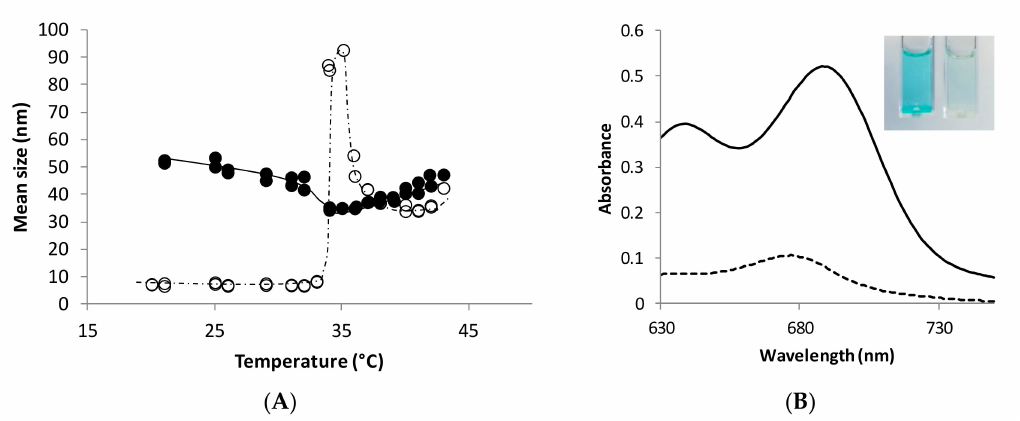
Figure 3. Aqueous solution behavior of the copolymers in phosphate bu ff er saline (PBS) (0.1 wt. %): ( A ) size (from dynamic light scattering (DLS)) vs. temperature for PLA-b-P(NIPAAm-co-PEGMA) ( • ) and P(NIPAAm-co-PEGMA) ( ); ( B ) UV-visible spectrum of cy5.5 incubated at room temperature (cid:35) with copolymer solutions (Cy5.5: 3.3 µ g · mL − 1 , copolymer: 1 ◦ mg · mL − 1 (0.1 wt. %) in PBS): PLA-b-P(NIPAAm-co-PEGMA) (back line, left photograph) and P(NIPAAm-co-PEGMA) (dotted line, right